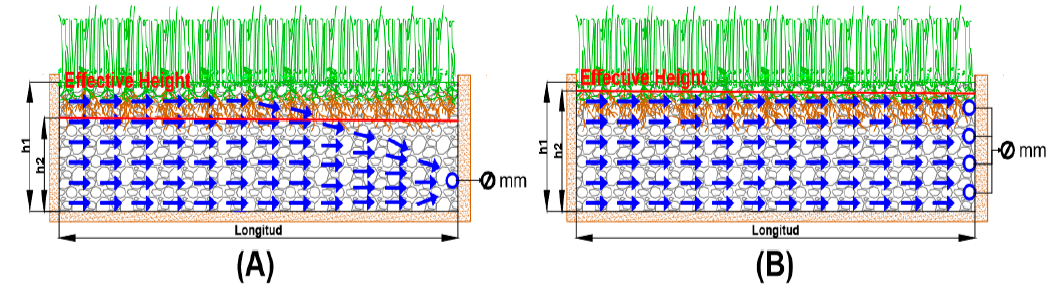
Figure 1. Effective height with ( A ) the conventional device and ( B ) the innovative device.